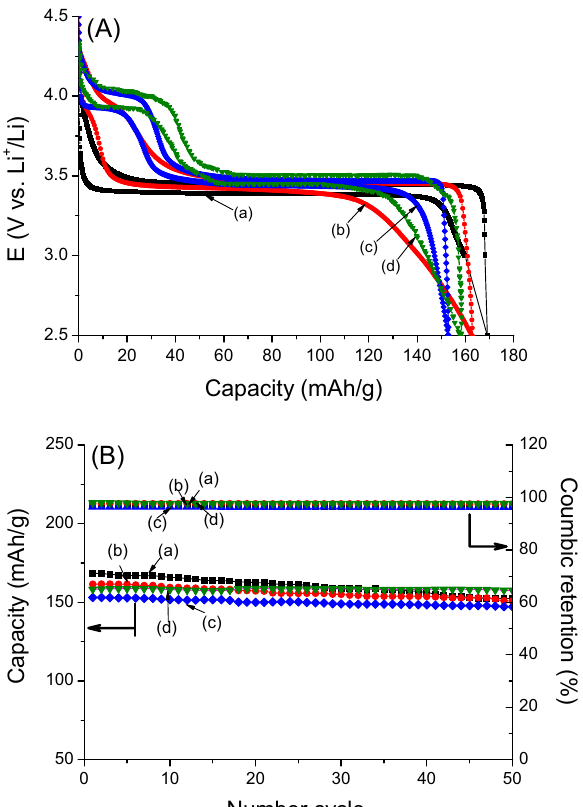
Figure 5. ( A ) Typical charge/discharge curves and ( B ) cycling performance upon 50 cycles of olivine samples at a rate 0.1 C: (a) LiFePO 4 ; (b) LiMn 0.1 Fe 0.9 PO 4 ; (c) LiMn 0.2 Fe 0.8 PO 4 and (d) LiMn 0.3 Fe 0.7 PO 4 . These figures have been presented using OriginLab Software, ver.6.0 (https:// www. origi nlab. com).